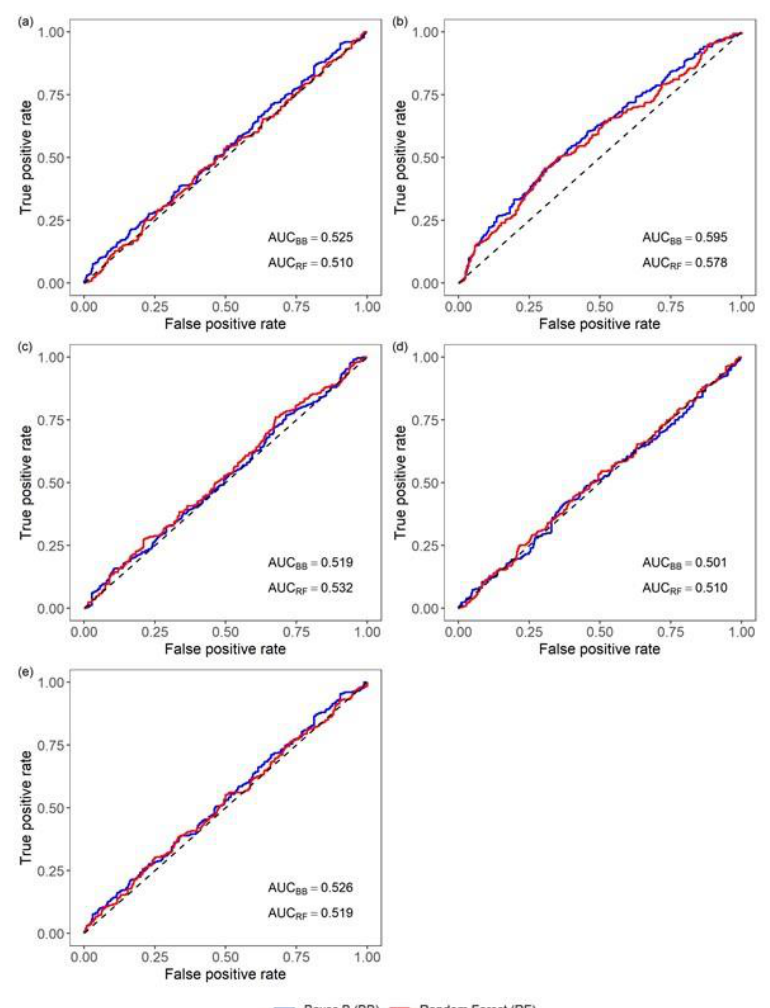
Figure A1. ROC curves for the classification of VNN mortality provided by the genomic predictions of ( a ) phenotype for mortality; ( b ) EBV FULL for mortality; ( c ) EBV FULL for body weight; ( d ) EBV FULL for the square root of serum cortisol concentration; ( e ) EBV FULL for antibody titer (EBV FULL : breeding value estimated using the animal phenotype and the phenotypes of its full- and half-sibs). In the figure, the Bayesian model producing the genomic predictions with the best classification perfor- mance (Bayes B, BB) is compared with the Random Forest algorithm (RF); the value of the area under the ROC curve (AUC) is reported for both the BB and RF curves.